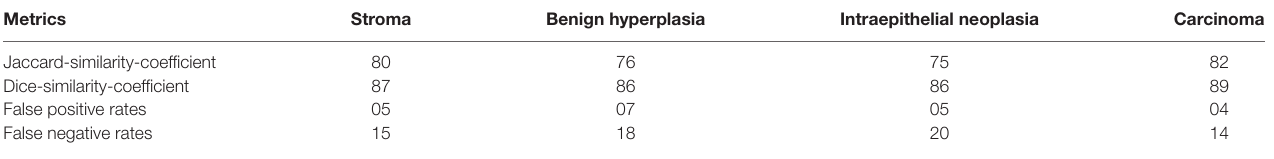
TaBle 1 | Average of similarity metrics between ground truth and segmented pathology lesions.